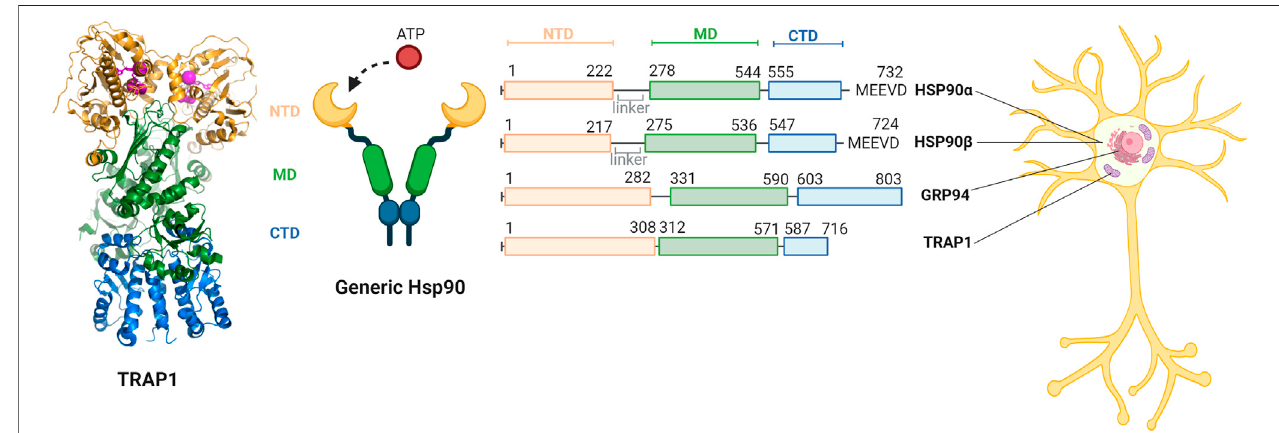
FIGURE 2 | Comparison of the domains of members of the human Hsp90 family and their relative cellular compartments. The family members each have a N-terminaldomain (NTD, yellow) responsible for ATPbinding, a C-terminaldomain (CTD, blue) responsible for dimerisation, and amiddle domain (MD,green).A generic structureoftheopencon fi rmationofHsp90isprovided.HSP90 α andHSP90 β arelocatedinthecytosolandcontainalinkerandtheMEEVDmotifthatrecognisesalarge part of their clients. GRP94 is located in the endoplasmic reticulum and does not contain a linker nor the MEEVD motif. TRAP1 is primarily located in the mitochondria does not have a linker or the MEEVD motif either. The structure of the TRAP1 dimer (PDB code 6XG6) is depicted on the left, with the domains in the represented colors and cofactors and ADP in lila (Liu et al., 2020). Figure made with